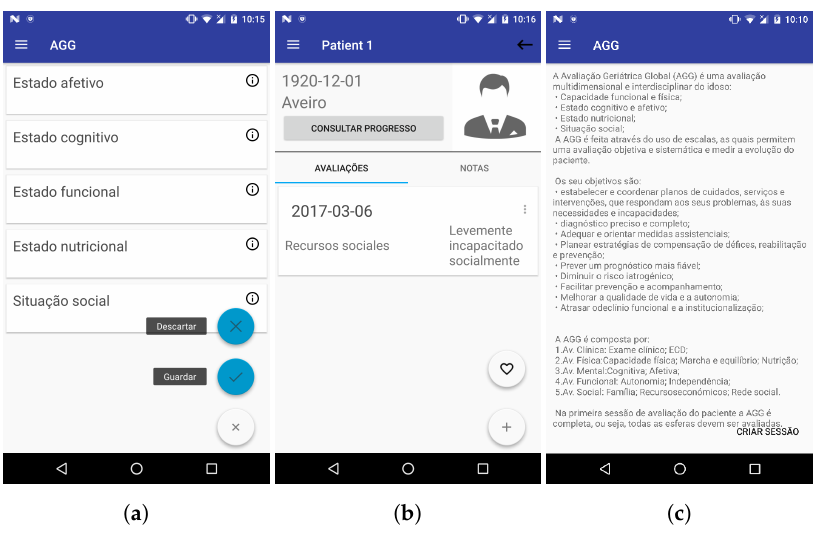
Figure 1. Several screen captures of Geriatric Helper’s first prototype: ( a ) menu depicting the different evaluation areas (affective, cognitive, functional, nutritional and social); ( b ) current status for ongoing session, with the social status assessment already performed (outcome: mild social incapacity); and ( c ) overall description of CGA purpose and components, deemed an issue to correct, during the heuristic evaluation, due to the amount and size of the